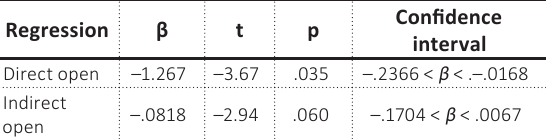
Table 6. Comparison of regression results for